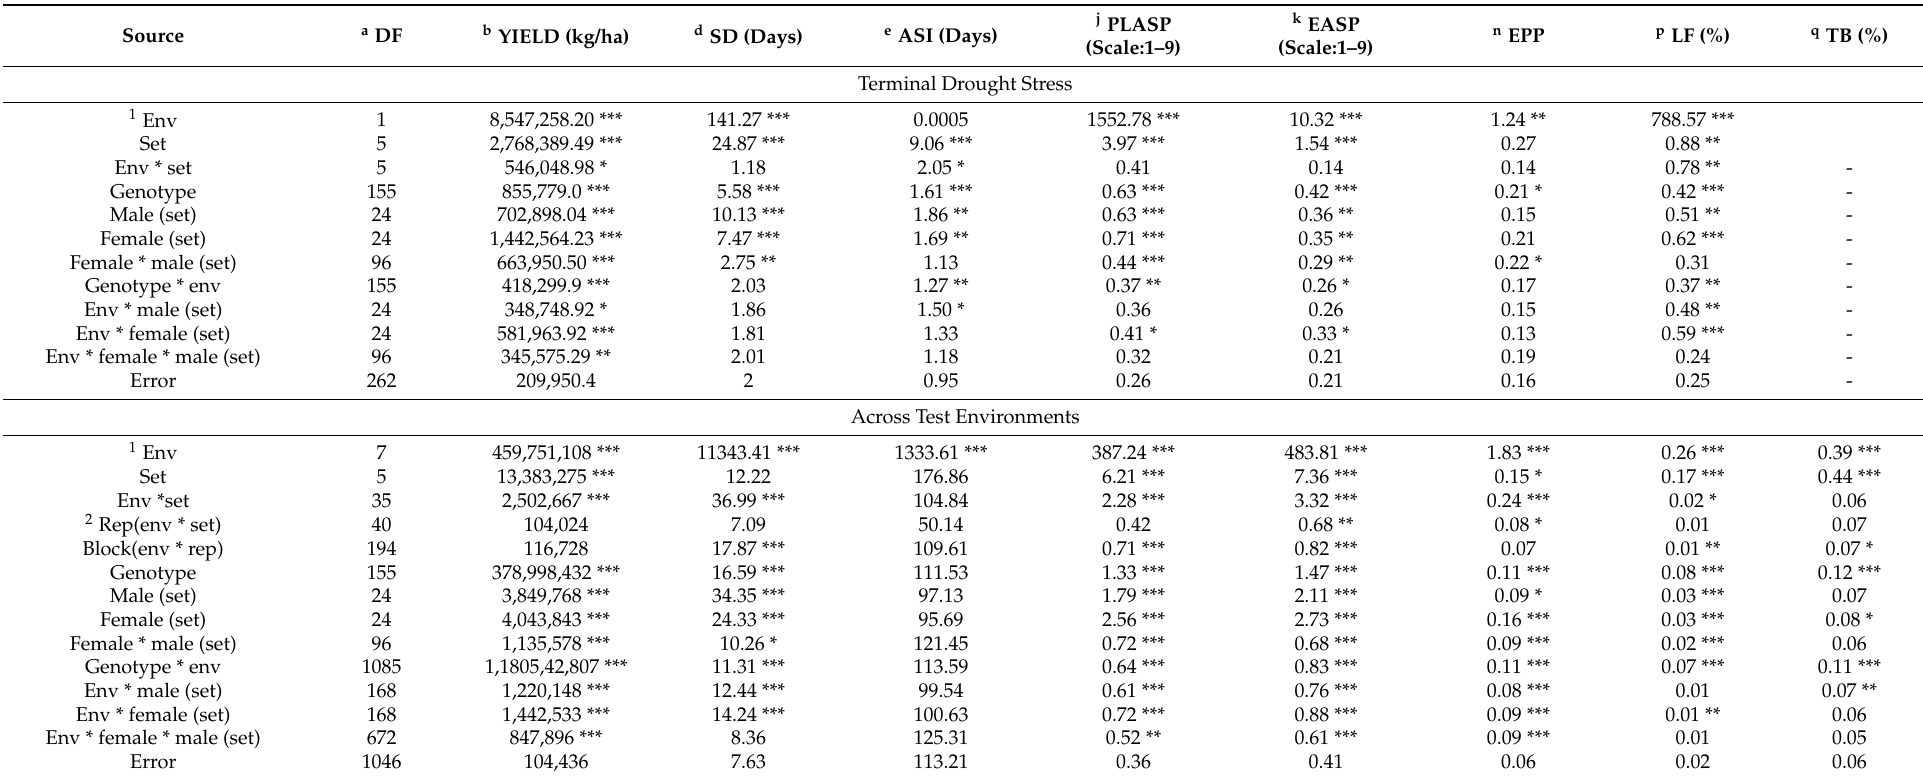
Table 2. Mean squares from combined analysis of variance of hybrid maize evaluated under terminal drought and across environments in Manga and Kadawa during the 2017/2018 dry